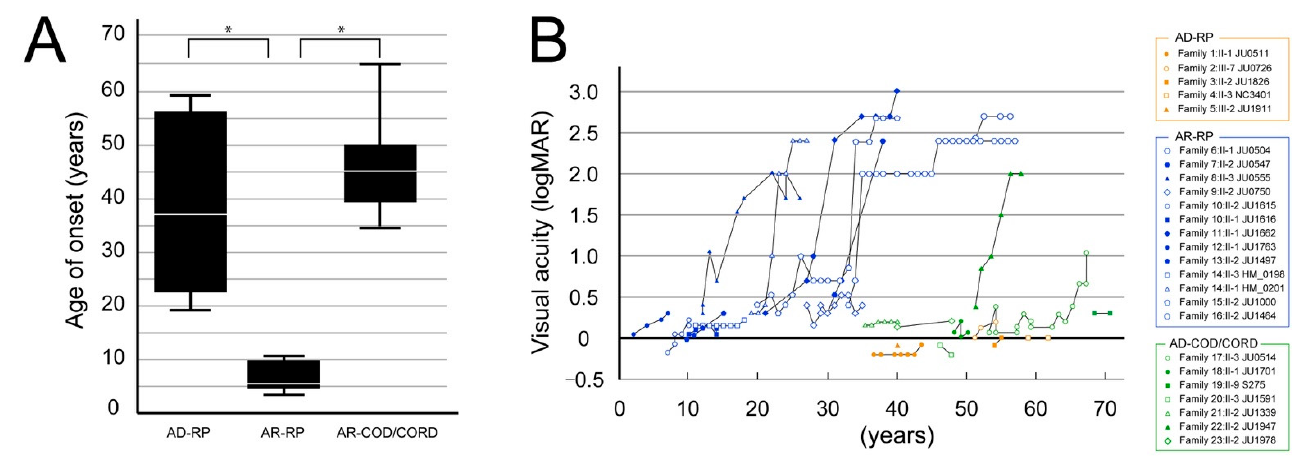
Figure 3. The age at onset and course of visual acuity findings are shown for the 3 phenotypes. ( A ) The graph shows the age at onset in patients with autosomal dominant (AD)-retinitis pigmentosa (RP), autosomal recessive (AR)-RP, and AR-cone dystrophy (COD)/cone-rod dystrophy (CORD). The age at onset significantly differed between patients with AR-RP and AD-RP ( p < 0.001, Bonferroni test) and between patients with AR-RP and AR-COD/CORD ( p < 0.001), but not between patients with AD-RP and AR-COD/CORD ( p = 0.508). The asterisks indicate statistical significance ( p -values <0.05). ( B ) The graph shows the course of visual acuity in patients with AR-RP (in blue), AD-RP (in orange), and AR-COD/CORD (in green). Visual acuity starts to worsen in patients with AR-RP around their 20s and reaches severe visual dysfunction by their 40s; in contrast, good visual acuity is preserved in patients with AD-RP until their 50–60s. Furthermore, visual acuity shows a tendency toward relative preservation in patients with AR-COD/CORD until their 50s, with subsequent deterioration and progressive macular atrophy.